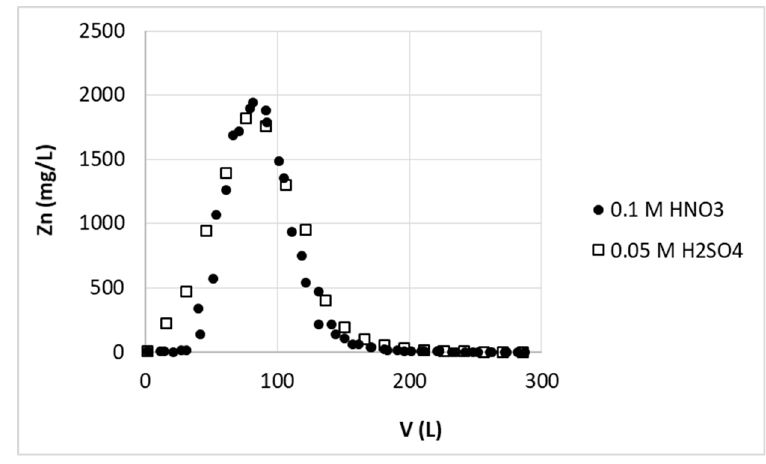
Figure 11. Effect of type of acid on zinc(II) ions stripping from hybrid pectin-based biosorbent. Mass of sorbent (dry form, large grain): 16 kg; flow rate: 30 L/h; stripping solution: 0.1 M HNO 3 or 0.05 M H 2 SO 4 .